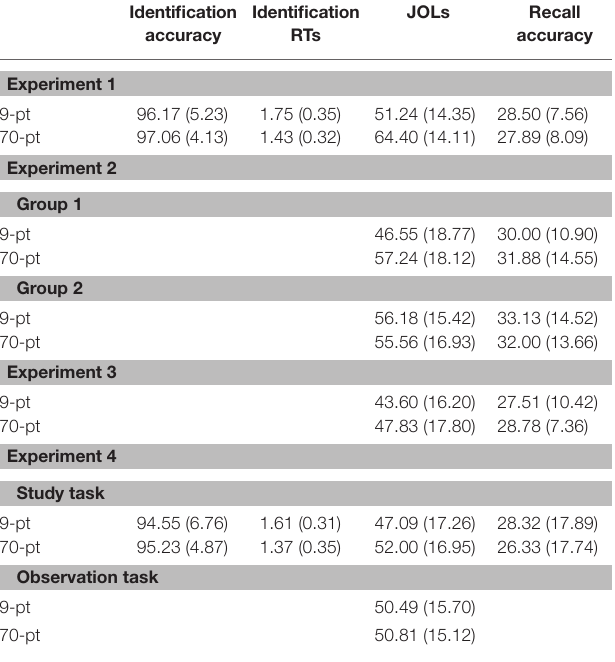
TABLE 1 | M ( SD ) of participants’ identification accuracy, identification RTs, judgments of learning (JOLs), and recall accuracy in Experiments 1–4.